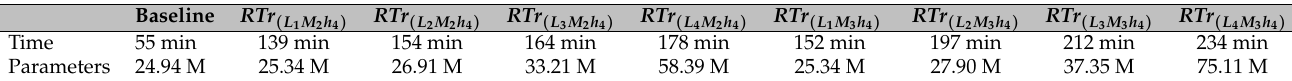
Table 4. Comparison on the Market dataset between the Residual Transformers in terms of training time (in minutes) and the number of parameters (in Millions).